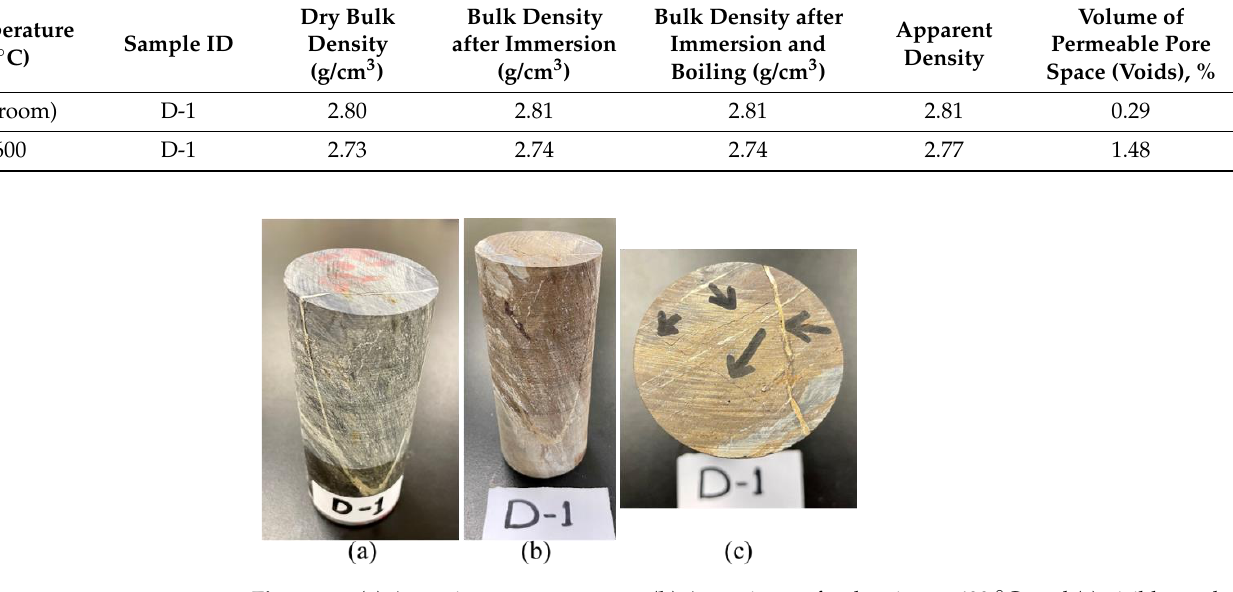
Figure 13. ( a ) A specimen at room temp, ( b ) A specimen after heating to 600 °C, and ( c ) visible cracks after heating to 600 °C.